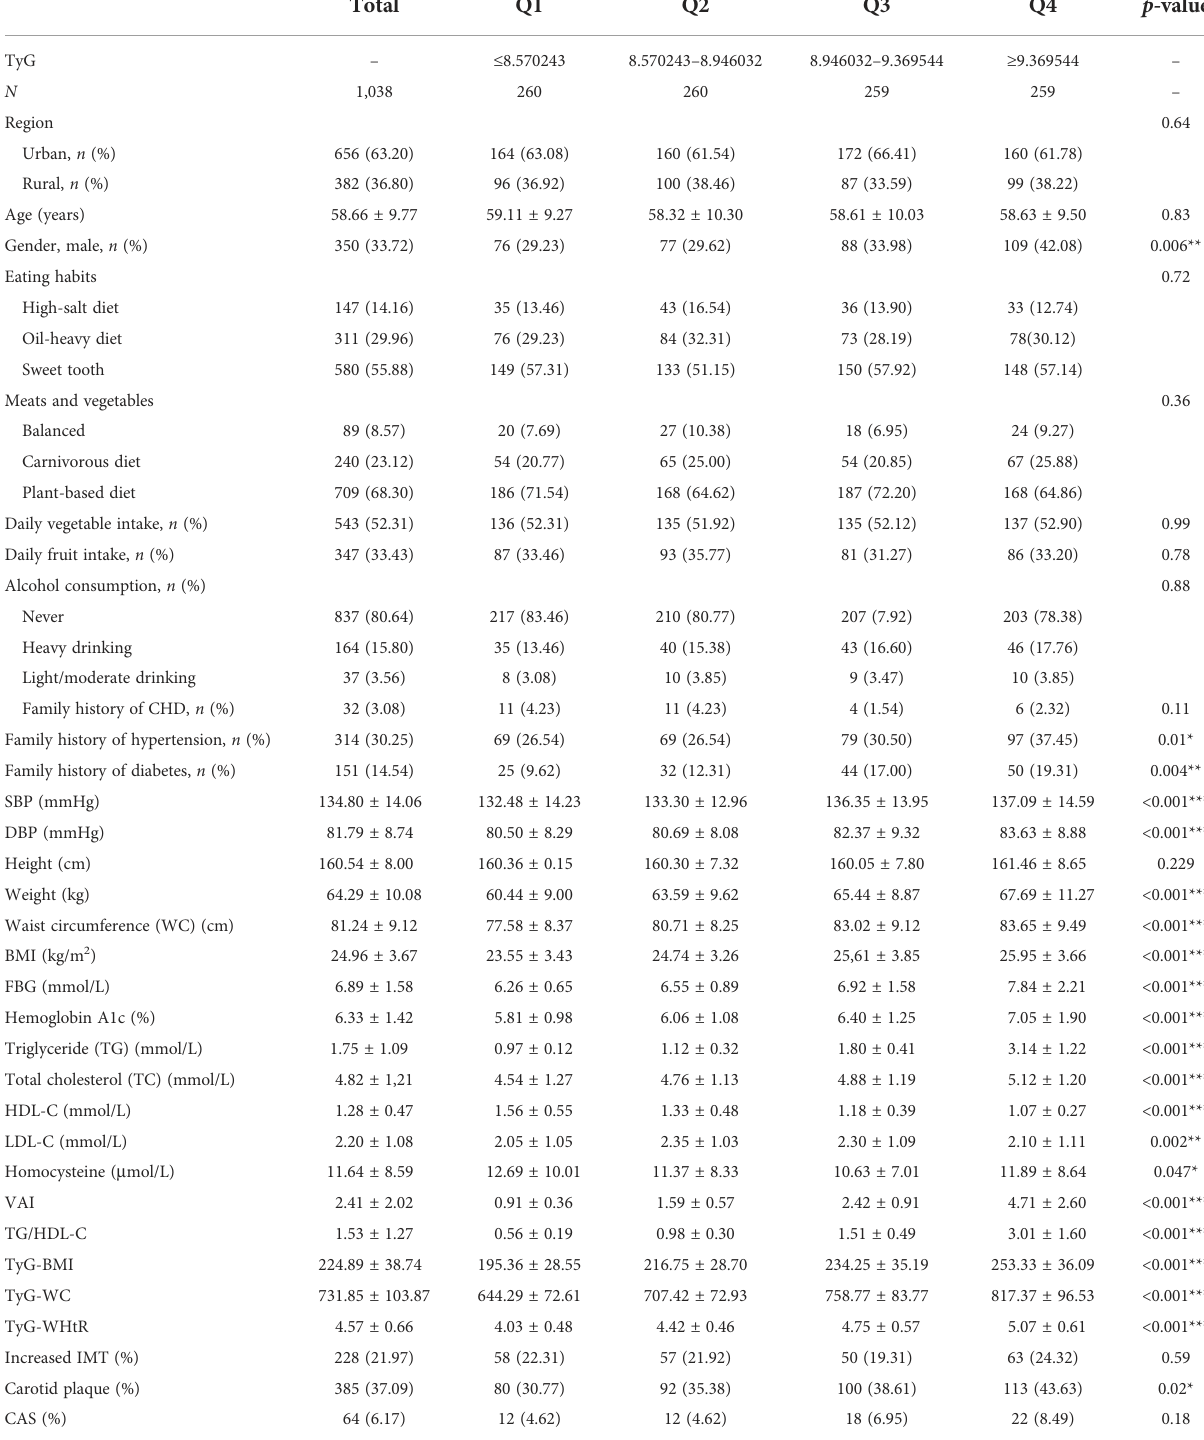
TABLE 2 Baseline characteristics by triglyceride – glucose (TyG) quartiles in the high-stroke-risk population. Total Q1 Q2 Q3 Q4 TyG